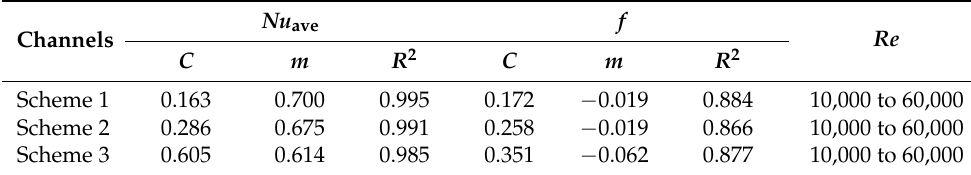
Table 3. Fitting parameter values of heat transfer and friction